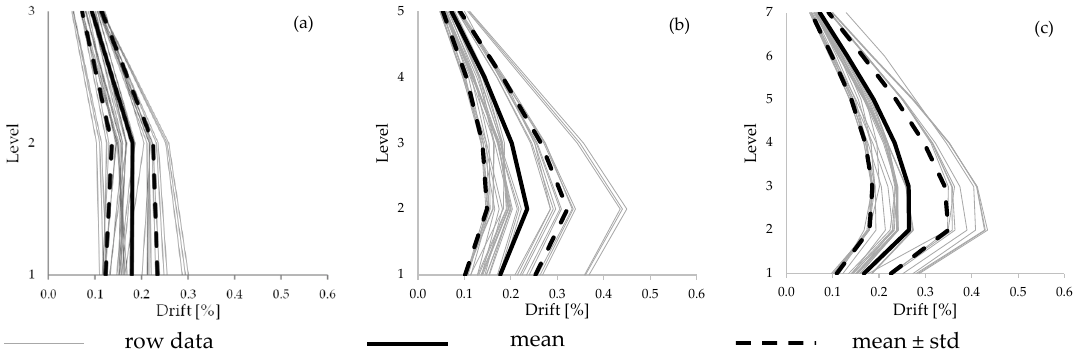
Figure 5. Distribution in height of the maximum inter-story drift ratio obtained from NLTH analyses for each base-isolated configuration: three-story ( a ), five-story ( b ) and seven-story building ( c ).